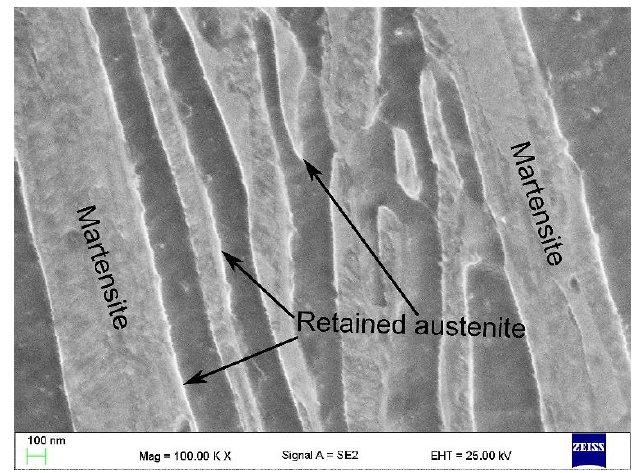
Figure 9. SEM micrograph of the sample intercritically annealed at 720 °C showing the retained austenite and martensite morphologies.